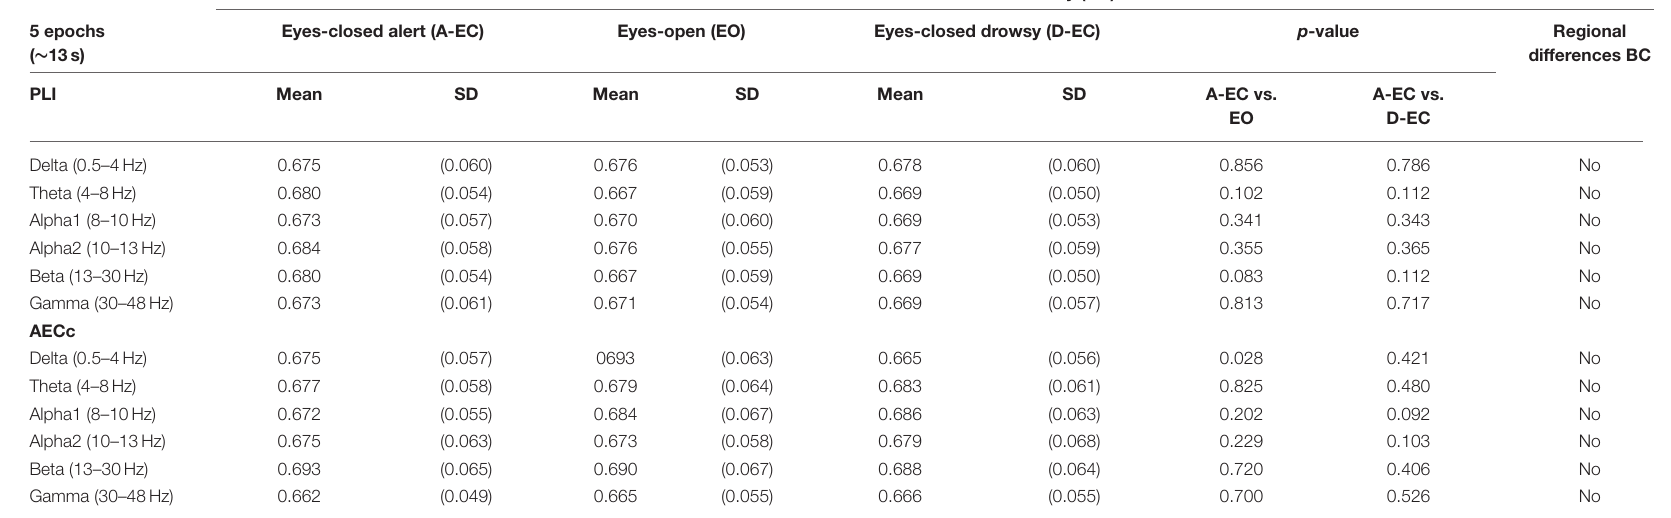
FFT, fast Fourier transform; PLI, phase lag index; AECc, corrected amplitude envelope correlation. Presented p-values are not corrected for multiple comparisons for the differences between states. * Regional differences: defined as “no” if none of the 78 cortical AAL ROIs had a significant (p < 0.05 after correction for multiple comparisons using FDR) between